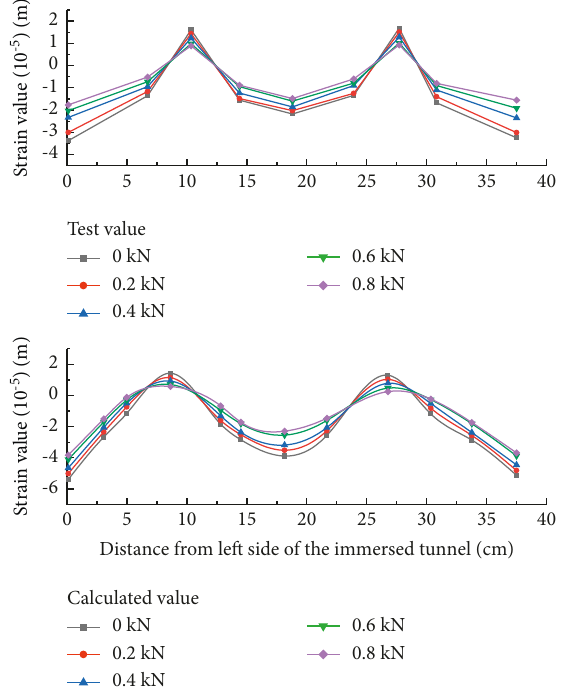
Figure 21: Immersed tunnel strain